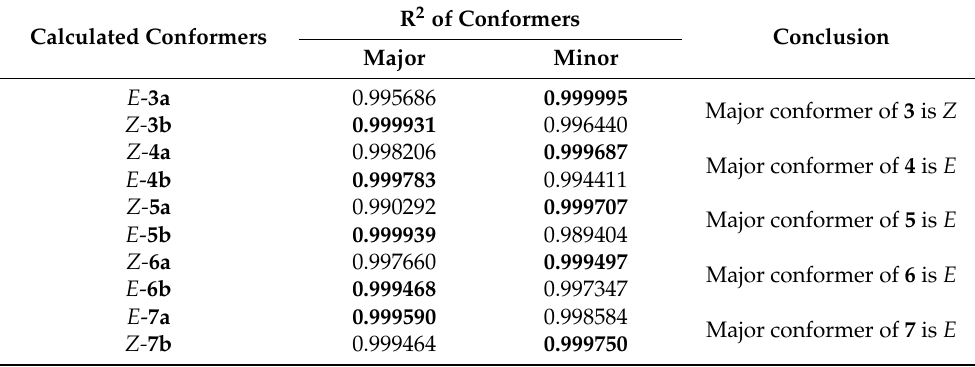
Table 5. Correlation coefficients of the calculated and experimental 13 C-NMR chemical shifts for N-nitrososarcosine 3 – 7